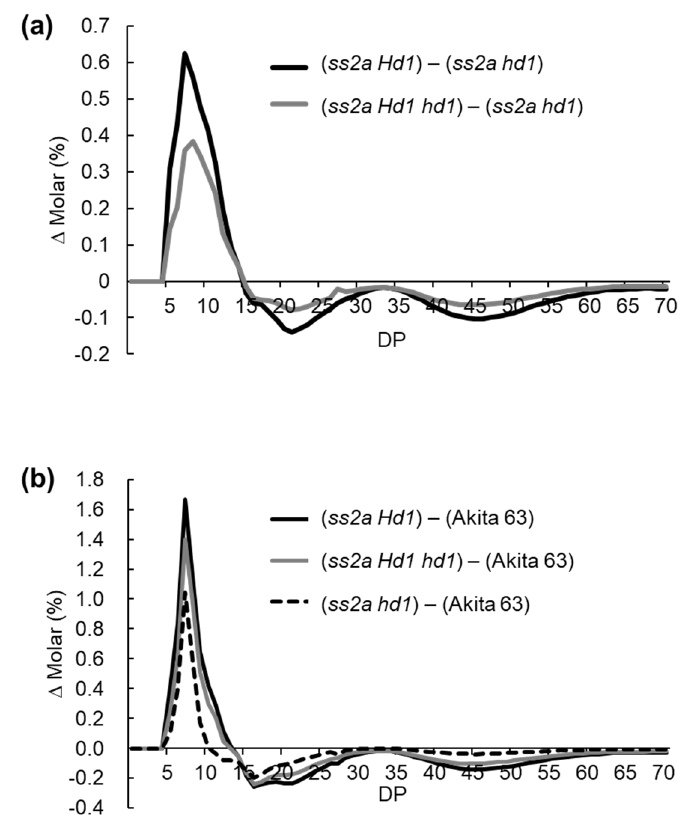
Figure 7. Differences in the amylopectin branch structure of NILs. ( a , b ) Subtraction curves showing the effects of Hd1 alleles on amylopectin branch structure ( a ) and the effect of the loss of SSIIa on amylopectin structure ( b ). Each panel shows one typical representative data set of at least three replications. Data shown here were obtained from samples harvested in 2021, and the data of samples harvested in 2020 are shown in Figure S3.